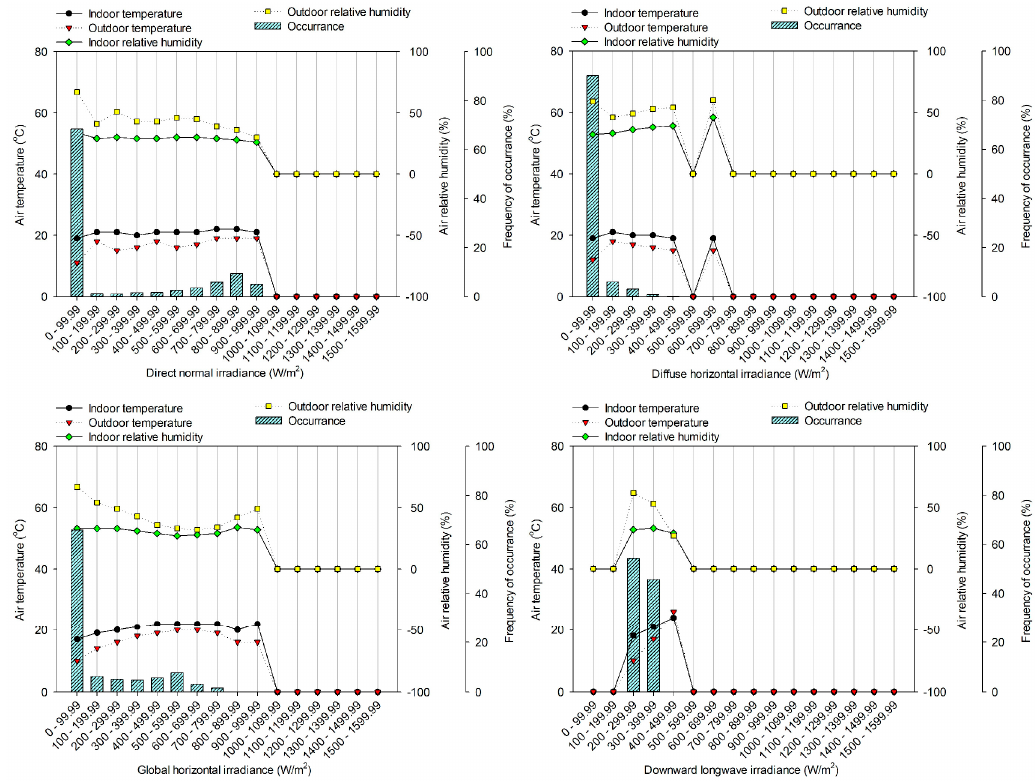
Figure 8. Indoor and outdoor thermal response to various components of solar radiation in winter.